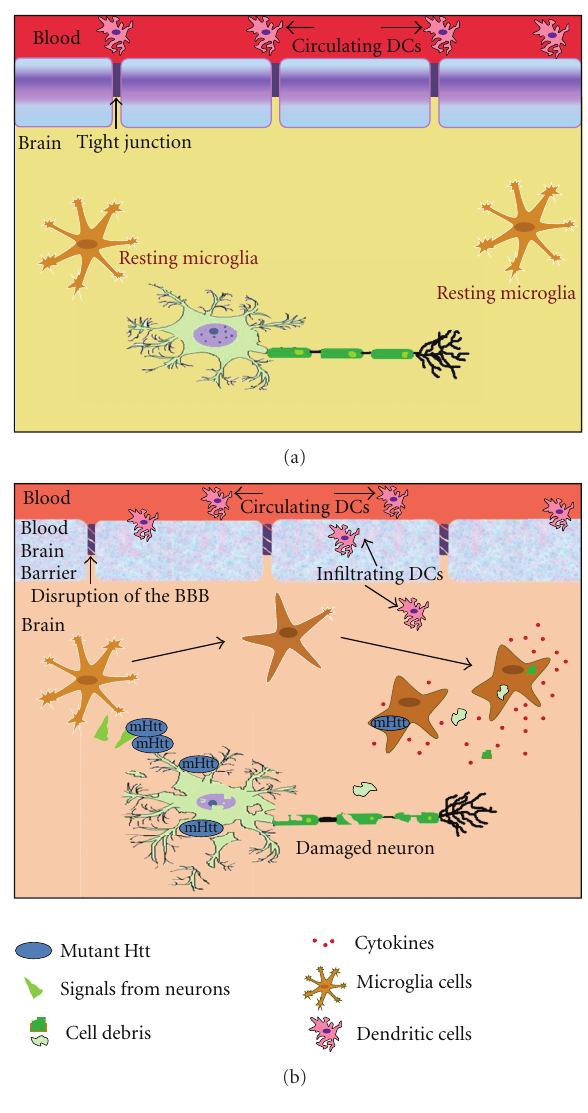
Figure 2: Comparison of immune activation in normal brain (a) versus HD brain (b). The normal brain is in a state wherein the microglia cells are in a resting state and are surveying its microenvironment. The BBB protects the brain from circulating immune cells such as DCs as well as pathogens and other foreign material. However, in the HD brain, the damaged neuron has aggregated mHtt and this activates the resting microglia cells and hence leads to phagocytosis of the cell debris along with secretion of proinflammatory cytokines that leads to neuroinflammation. This neuroinflammation weakens the BBB leading to infiltration of DCs and further elicits the immune response. Microglia cells that express mHtt also contribute to the inflammation and degeneration of the brain